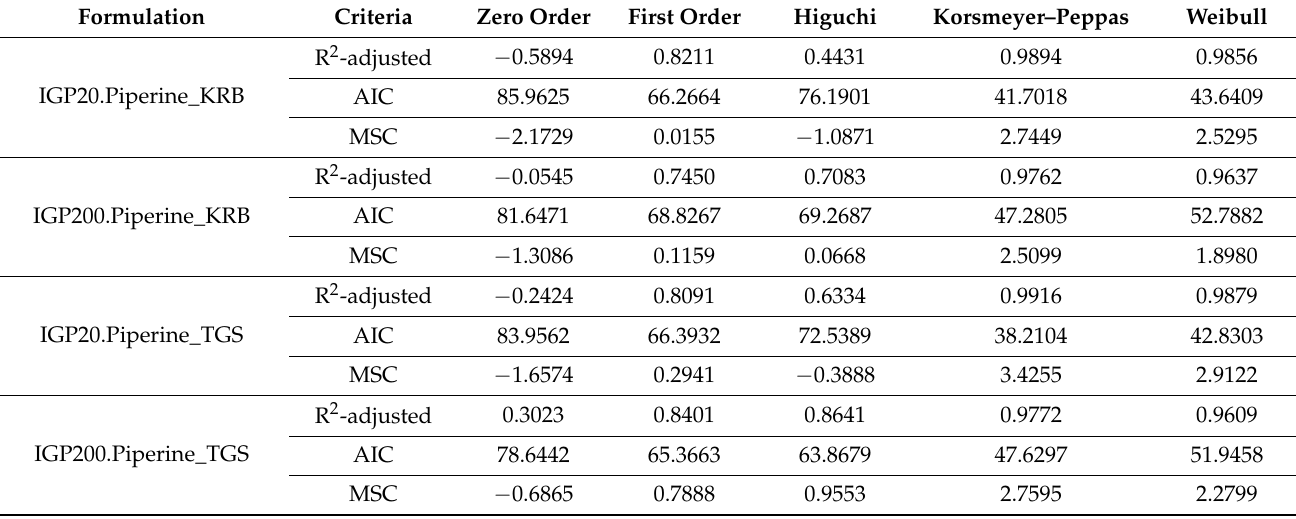
Table 4. Kinetic analysis results of the dissolution